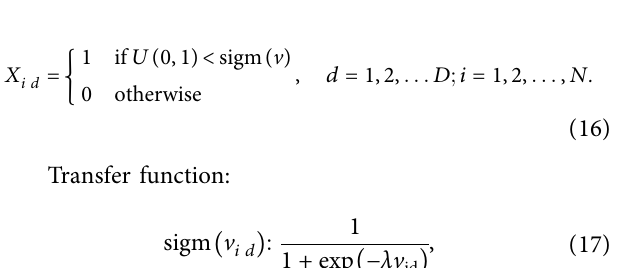
Figure 6: Procedure for HoG technique